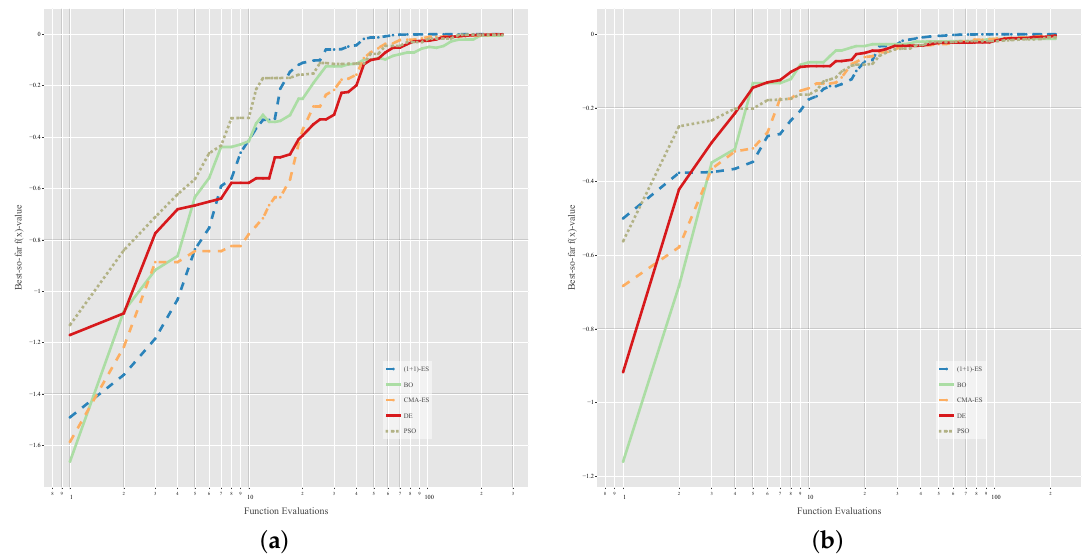
Figure 9. Average convergence graphs of the algorithms’ best-so-far (abscissa is in log-scale). ( a ) Case study 1—River Paglia; ( b ) Case study 2—River Aniene.